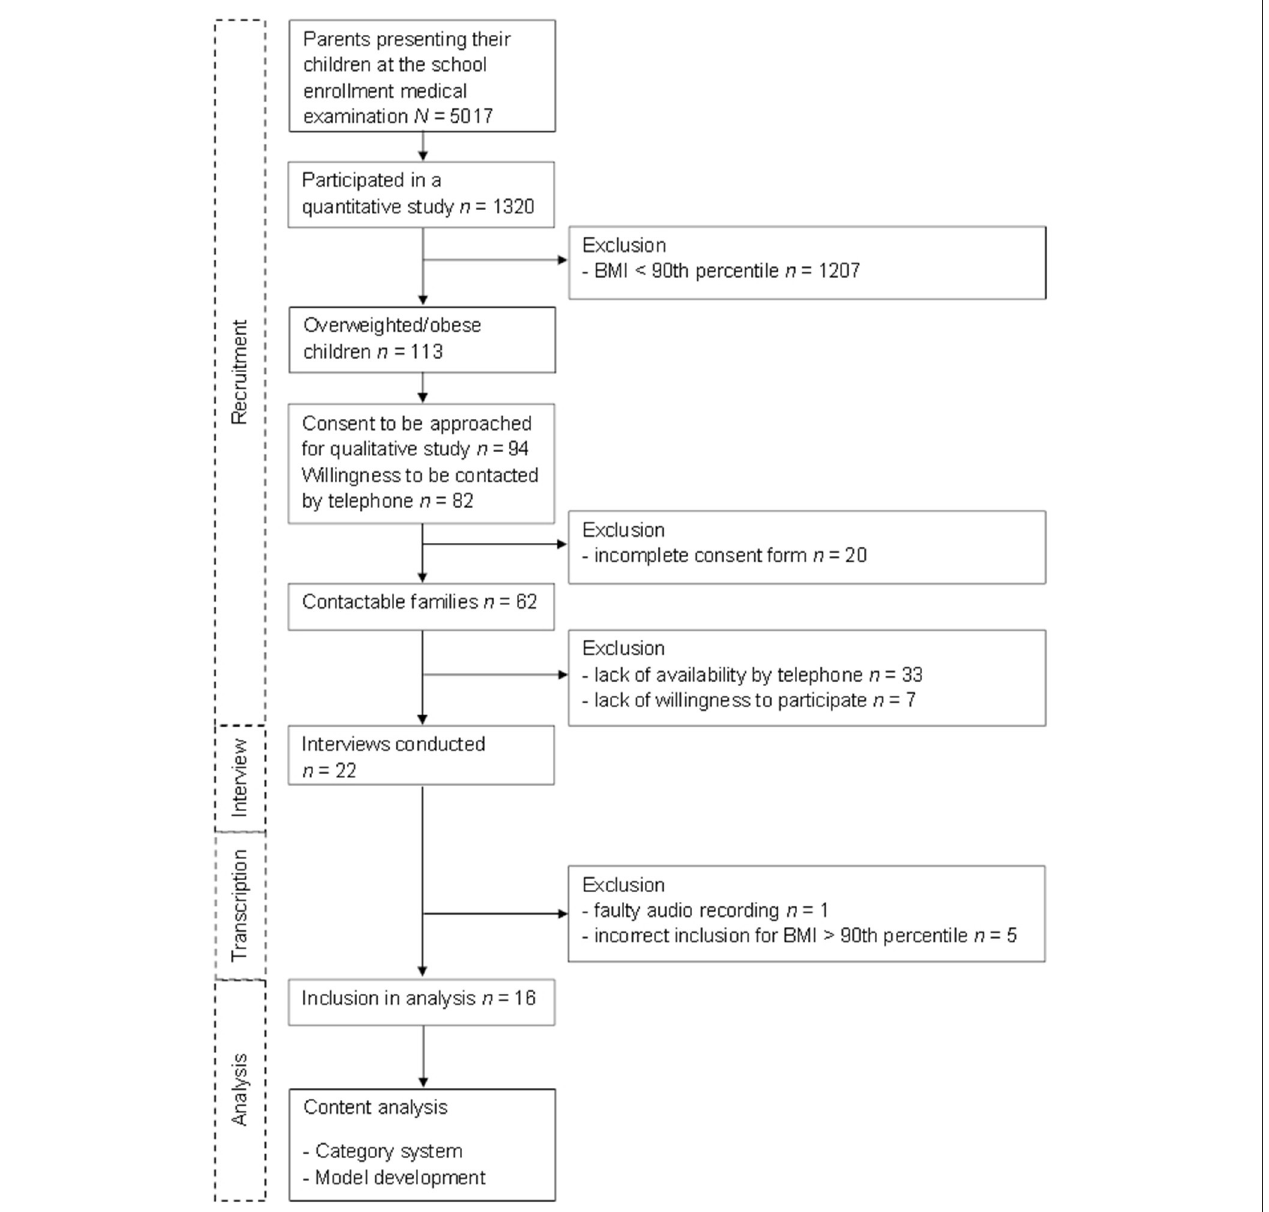
FIGURE 1 | Flow diagram of the study enrollment and analysis